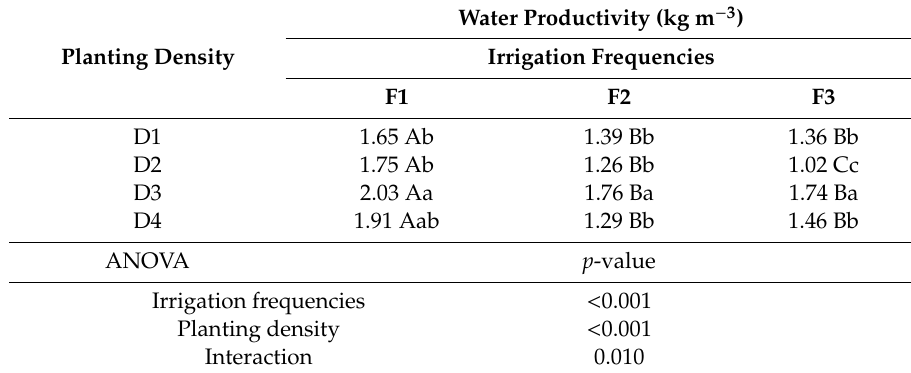
Table 7. Bean’s water productivity as a function of di ff erent irrigation frequencies and planting densities.